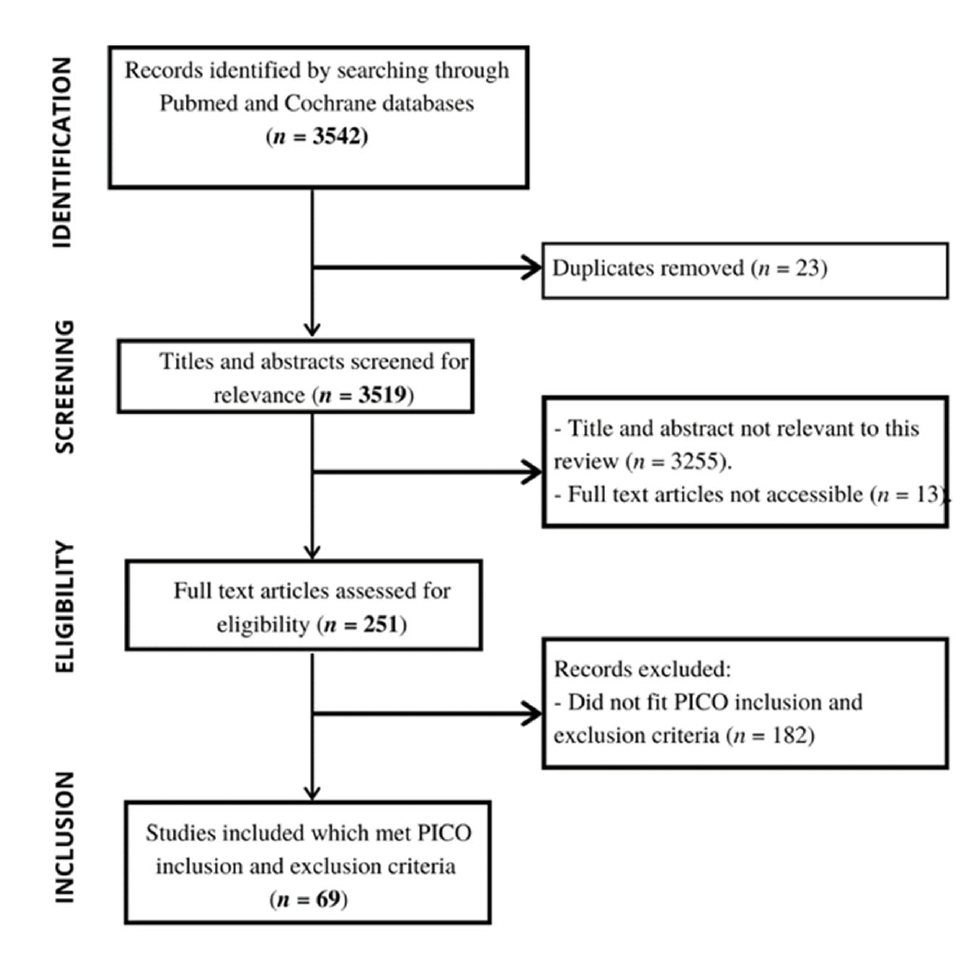
Figure 1. Flow diagram of the article screening Figure 1. flow diagram of the article screening process.